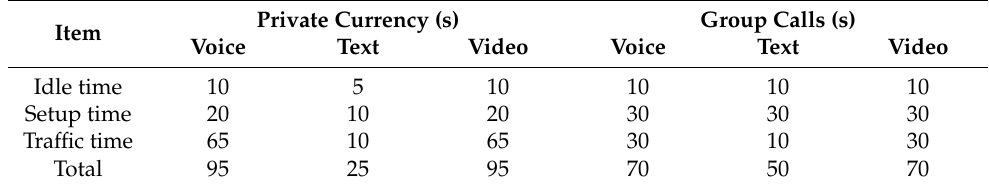
Table 5. Measured call time for each call.